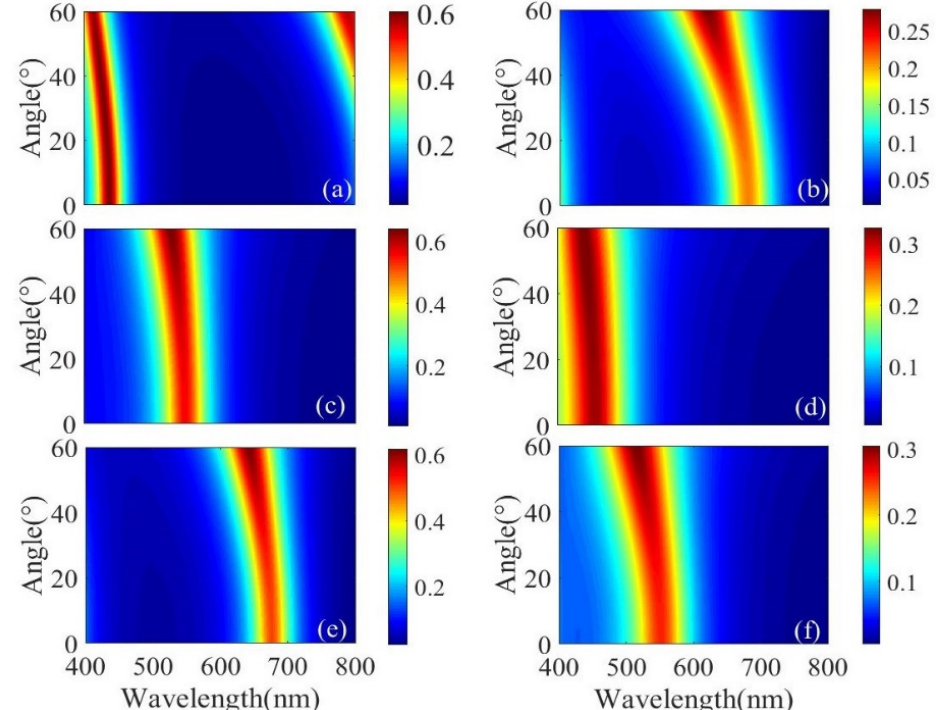
Figure 8. For low-conductivity films, the transmission spectra are functions of the wavelength and incident angle of ( a ) B, ( c ) G and ( e ) R colors, respectively. For high-conductivity films, the transmission spectra are functions of the wavelength and incident angle of ( b ) R, ( d ) B and ( f ) G colors,